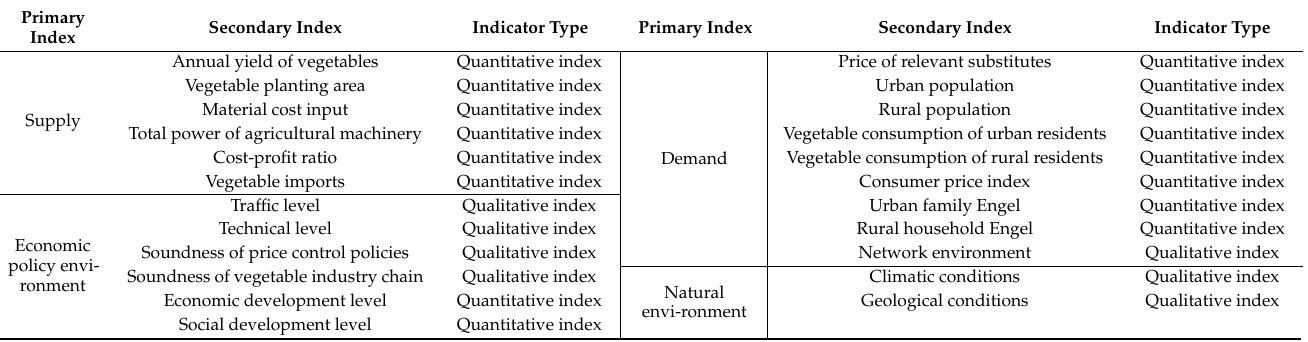
Table 6. Index system of interference sources of vegetable price